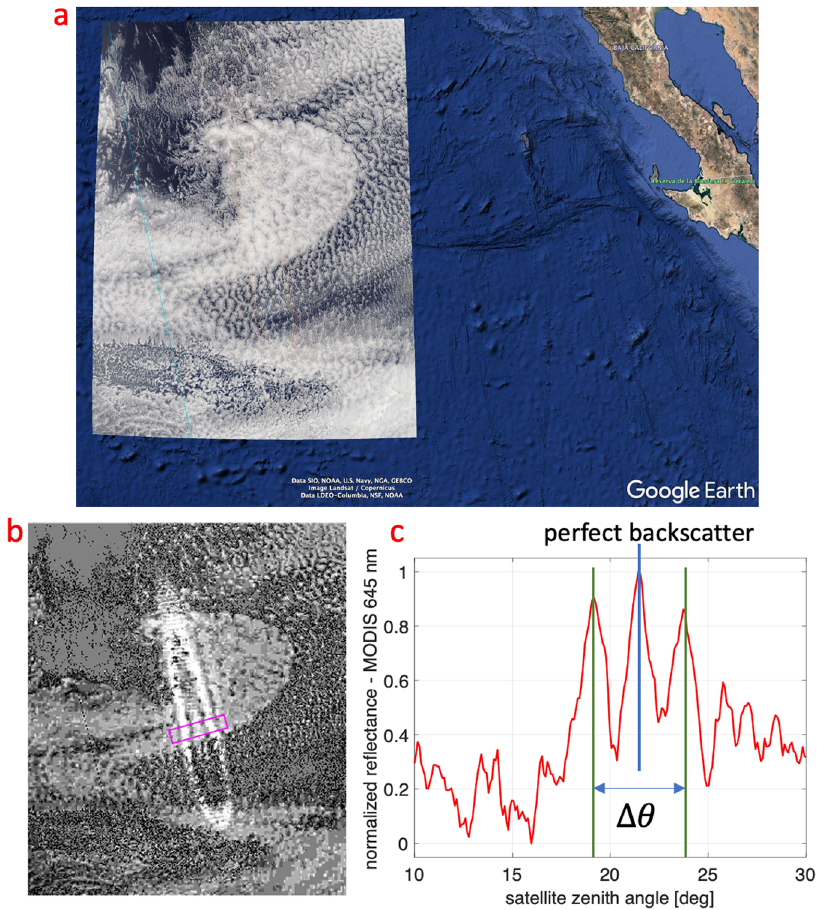
Fig. 2 A faint yet discernible glory in a satellite image of marine Sc west of Baja, CA, taken on May 29, 2021,~13:30 local time, by a moderate resolution imaging spectroradiometer (MODIS) on board the Aqua satellite. a True color image, projected on the Google Earth platform, where a faint glory is discernible near the center and the blue line is the nadir track of Aqua. b Subtracting the red from the blue channel ampli fi es the glory. Clouds are white because their red and blue re fl ectances are similar but the difference image captures wavelength-dependent features such as the glory. For the lower part of the glory, despite the clouds there being optically thin, single scattering, causing the glory, displays the fi rst ring, the central backscatter, and a weaker second red ring. The shape of the glory ring permits a geometric estimate of droplet sizes that is tolerant of imperfections in the instrument ’ s calibration and is apparent even for the thinnest clouds. Moreover, the elongation induced by the satellites motion, allows for a broader usage of glory information that could be used to invert droplet properties over wider portion of the cloud fi eld. c Re fl ectance measured by the MODIS red channel ( fi lter range: 620 – 670 nm) across the glory as demarcated by the magenta box in b . The glory ’ s signal is evident on either side of the exact backscatter peak, allowing for angular size and related magnitudes conversion to the droplets average diameter and its variance (see